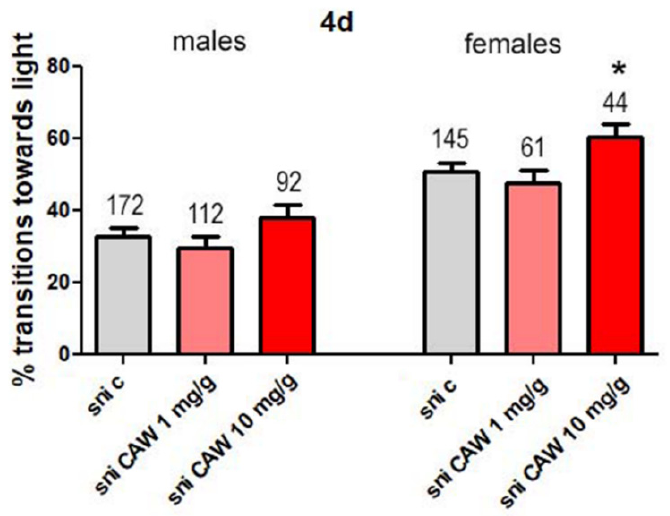
Figure 3. Percentage transitions towards light for sniffer (sni) flies treated with Centella asiatica water extract (CAW; 1 mg/g and 10 mg/g). Sniffer mutants were fed standard food (c) or standard food supplemented with CAW (1 mg/g or 10 mg/g) for 4 days. Fast phototaxis was performed with flies in groups of 10–20 flies and separated by experimental group and sex. The number of flies tested is indicated above the bars. Error bars represent SEMs. * = p < 0.05. With female sniffer flies the difference in transitions towards the light between con- trol flies and treated flies was not significant at 1 mg/g CAW but there was significant improvement with 10 mg/g CAW (Figure